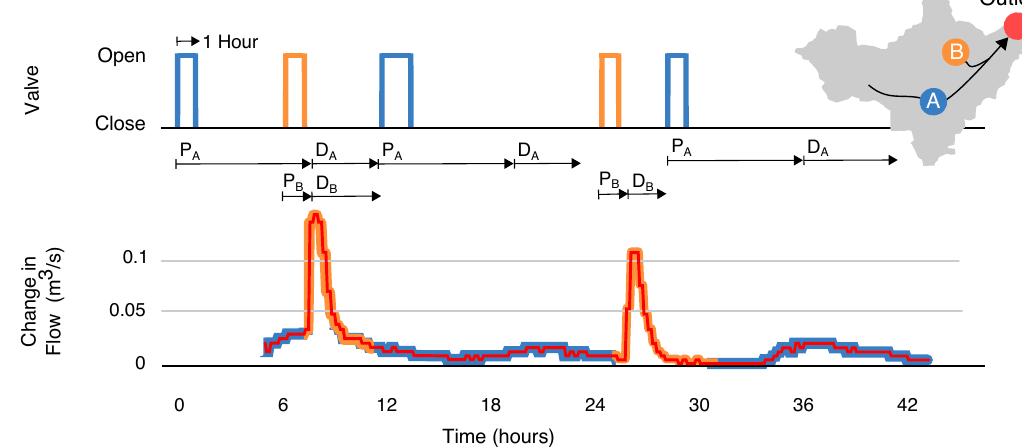
Figure 7. Superposition and interleaving of waves from retention basins A and B. Overlapping waves (coincident peaks) are generated from hours 6 to 12. Interleaved waves (off-phase peaks) are generated from hours 18 to